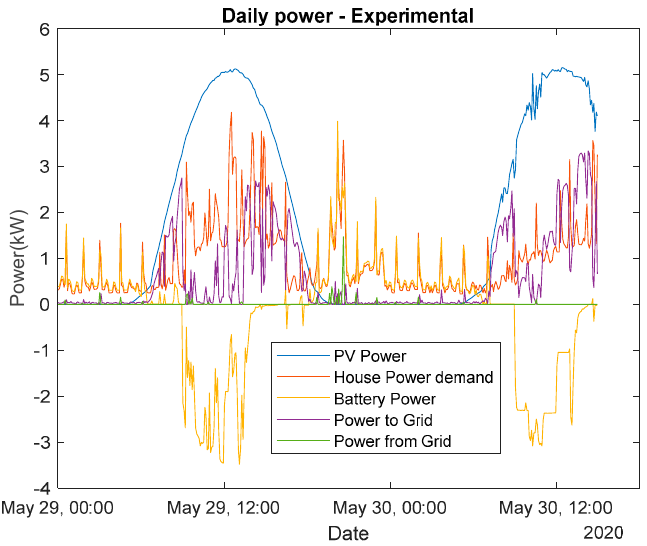
Figure 21. Different power signals, proprietary control (sunny day).